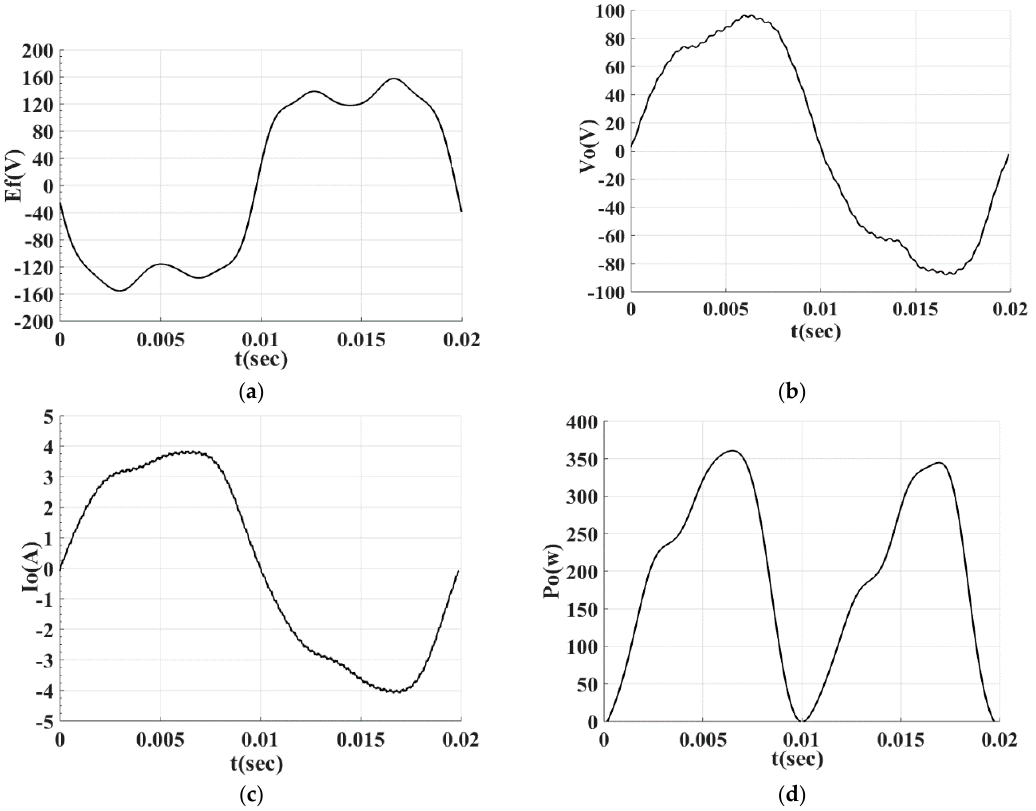
Figure 17. Experimental results: ( a ) no load voltage; ( b ) full load voltage; ( c ) full load current; ( d ) output power in full load.